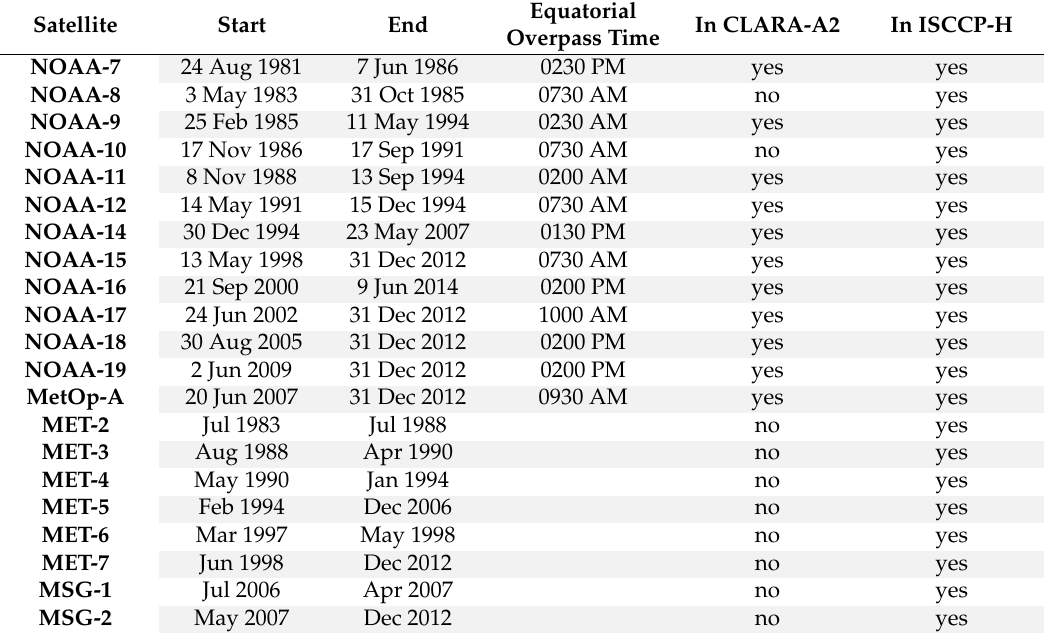
Table 2. Satellites and their temporal coverage in CLARA-A2 and ISCCP-H. Only the satellites covering the European study domain and being operational before the end of the study period (31 Dec 2012) are